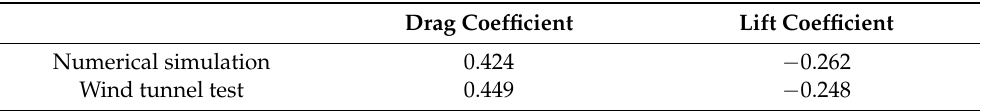
Table 1. Verification of grid reliability.